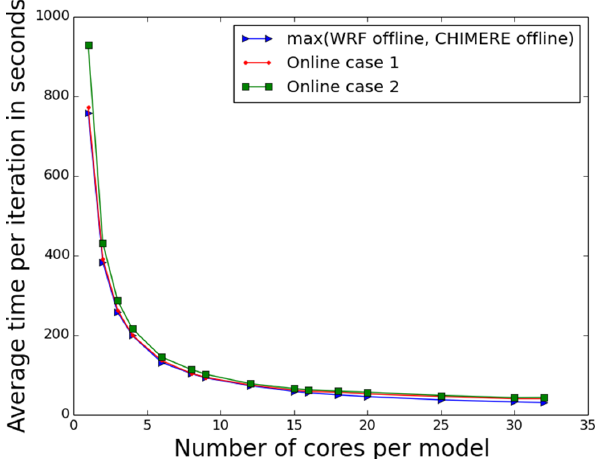
Figure 6. Evolution of the time increase from the offline simulation of both online simulations, as a function of the number of cores per model. Online case 1 refers to the online simulation without the aerosol optical properties feedback and online case 2 refers to the online simulation with the aerosol optical properties